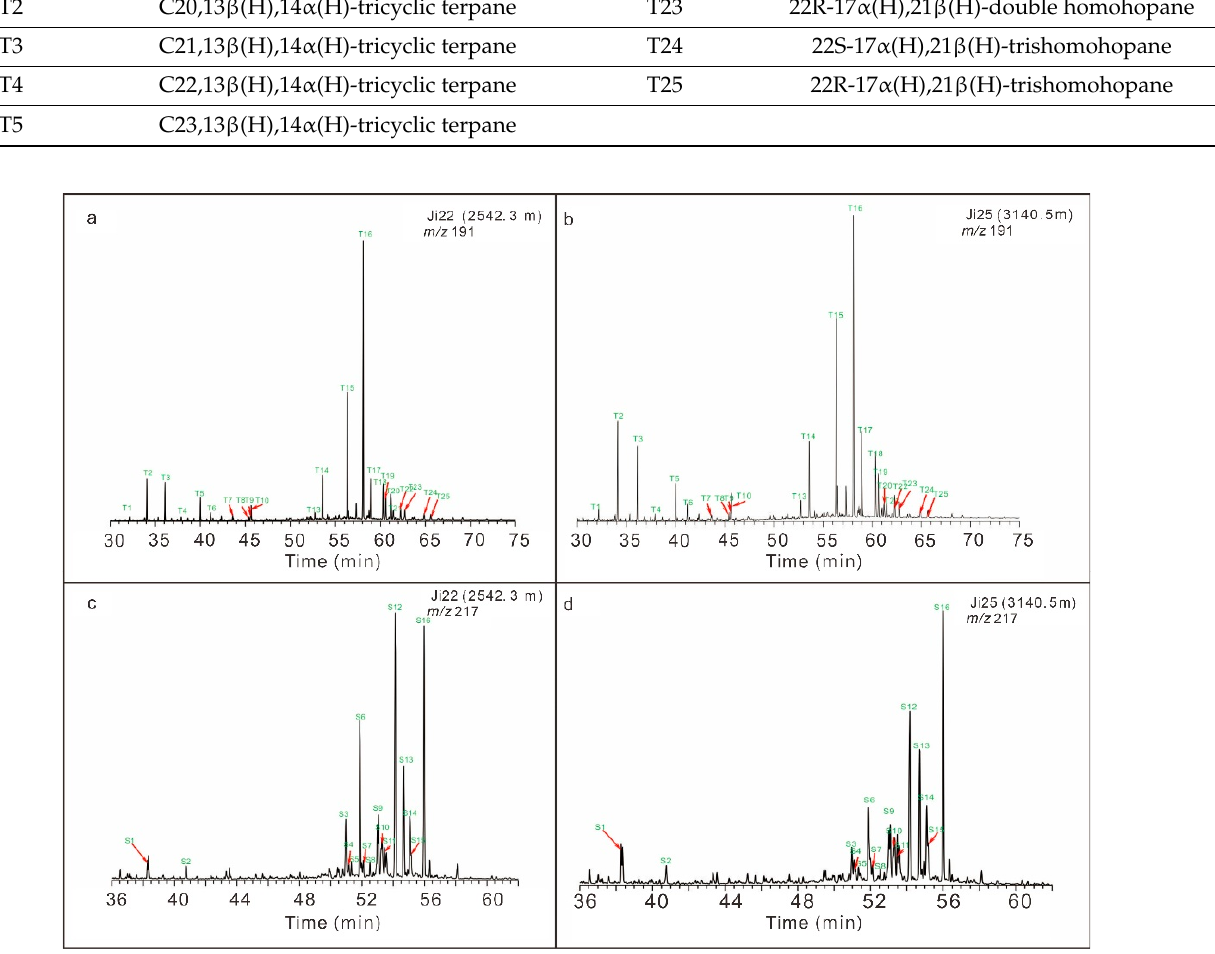
Figure 3. Gas chromatography–mass spectroscopy (GC–MS) spectra of the biomarkers of the ( a , b ) terpanes ( m / z 191) and ( c , d ) steranes ( m / z 217) in the P 2 l source rocks in the Jimsar Depression (the compounds corresponding to all of the labels are shown in Table 2).